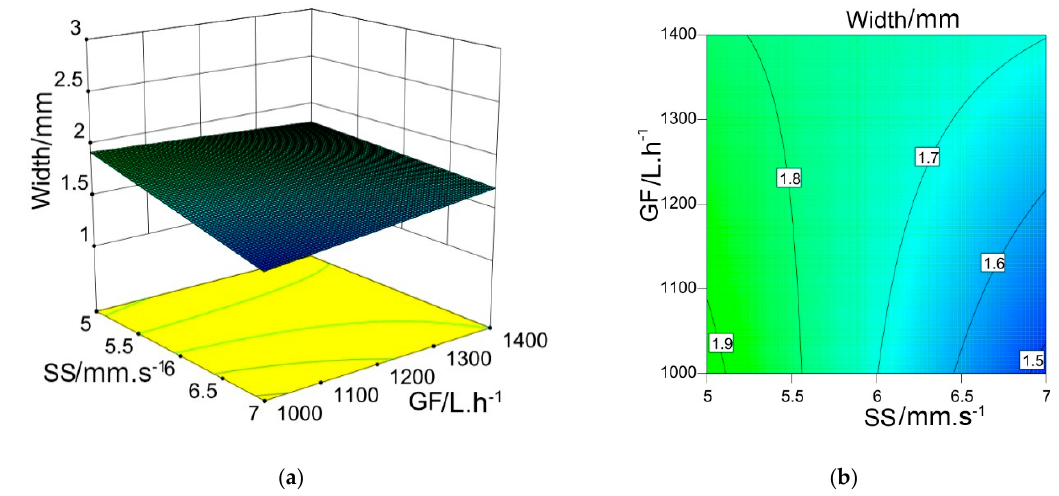
Figure 7 . ( a ) 3D response surface showing the influence of scanning speed and gas flow on clad width. ( b ) Contour line of the response surface.